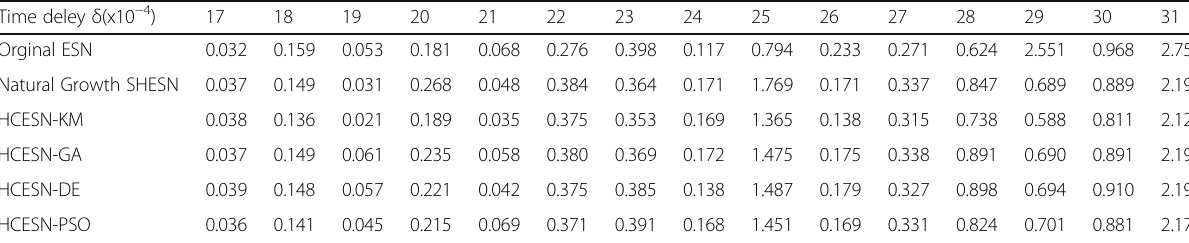
Table 5 Standard deviation for Mackey-Glass system